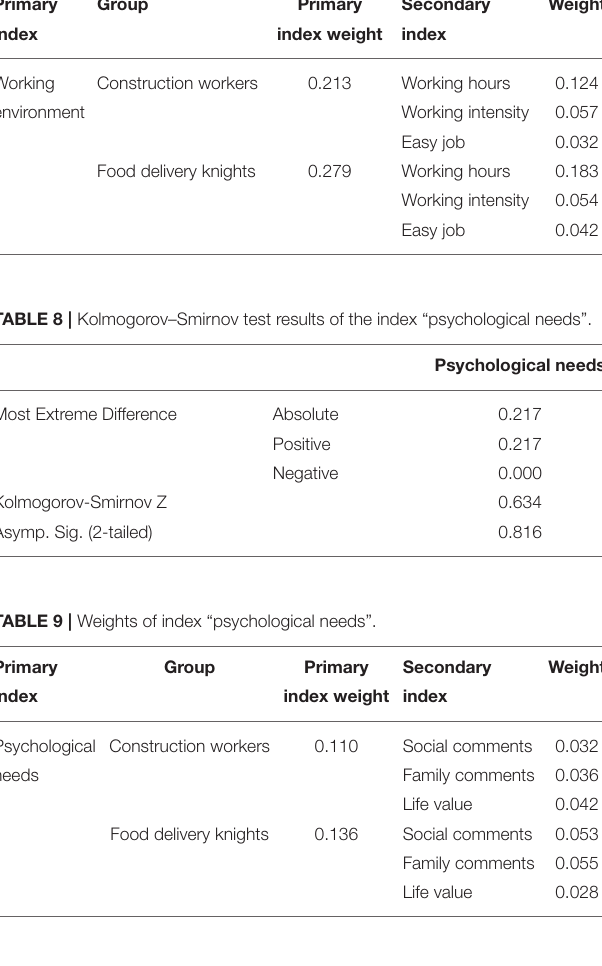
TABLE 11 | Weights of index “personal